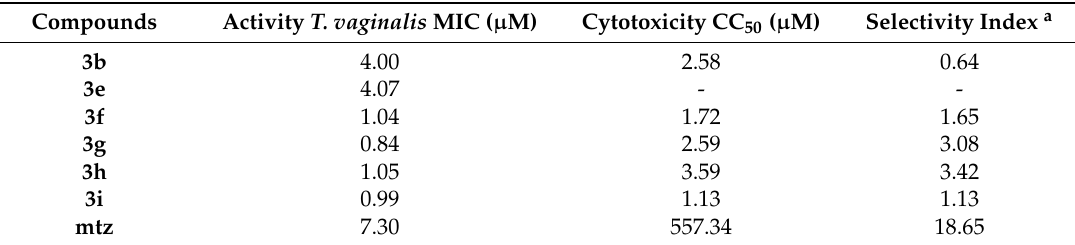
Table 10. Antiparasitic evaluation on T. vaginalis .